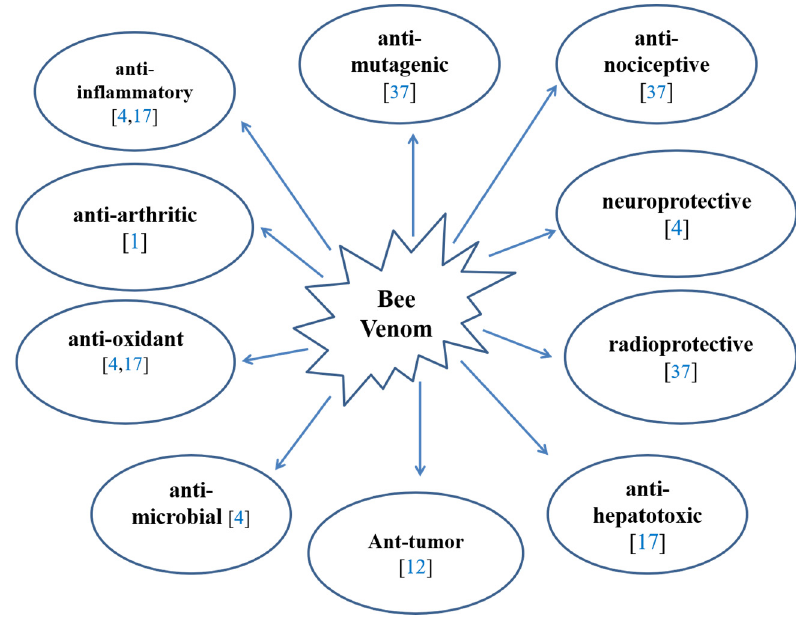
Figure 1. Pharmacological activities of bee